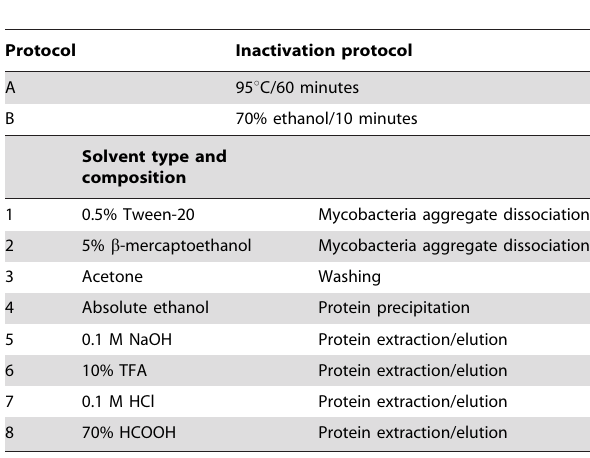
Table 2. Inactivation protocols and solvents used to treat mycobacteria for identification by MALDI-TOF